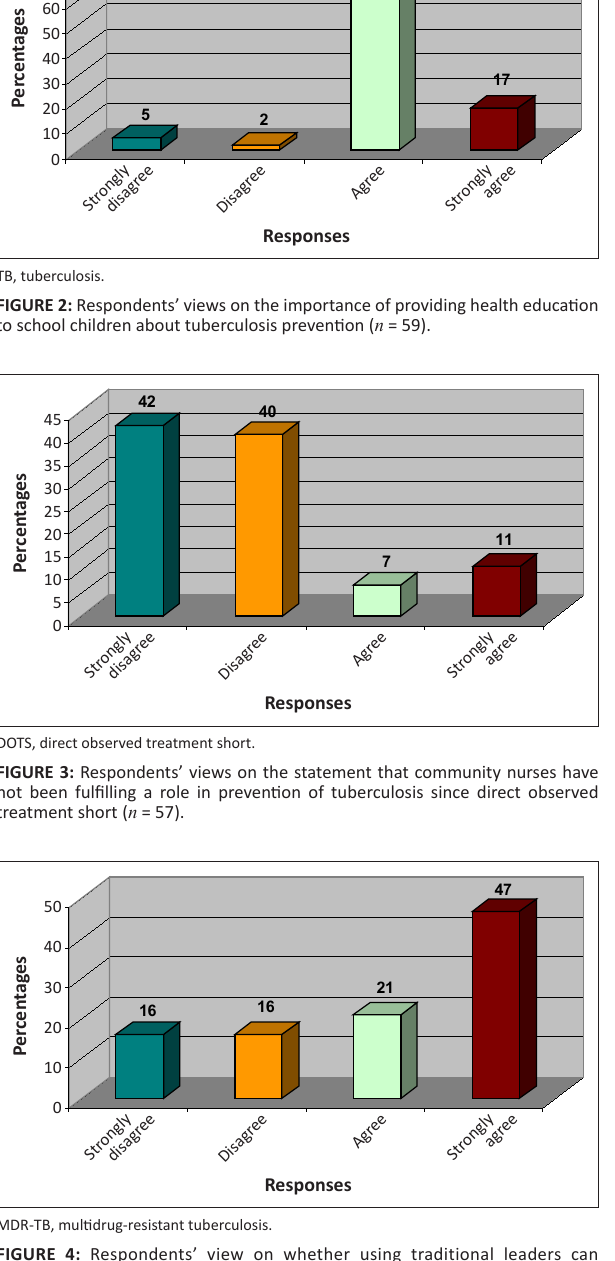
FIGURE 4: Respondents’ view on whether using traditional leaders can contribute to prevention of multidrug-resistant-tuberculosis ( n =